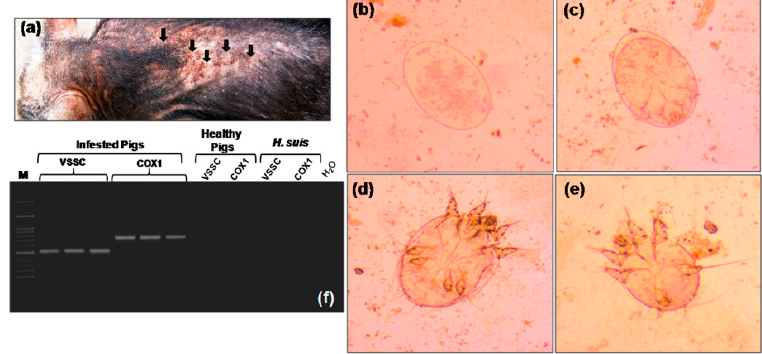
Figure 1. Sarcoptes scabiei infestation in Nicobari pig. ( a ) An infested animal with thickened and wrinkled skin and hair loss (black arrows), ( b ) mite egg (400 × magnification), ( c ) mite egg containing larvae (400 × magnification), ( d ) mite nymph (400 × magnification), ( e ) larval stage of mite (400 × magnification), ( f ) amplification of cytochrome C oxidase subunit 1 (COX1) and voltage sensitive sodium channel (VSSC) gene segments. Infested animals were positive for both of the gene fragments whereas control animals were negative. Primer specificity was verified using the lice ( Haematopinus suis ) DNA as negative